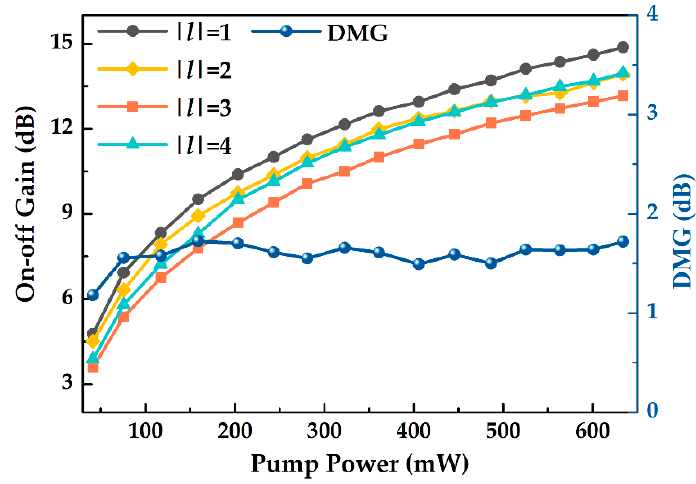
Figure 7. The OAM mode on–off gain and DMG versus pump power.